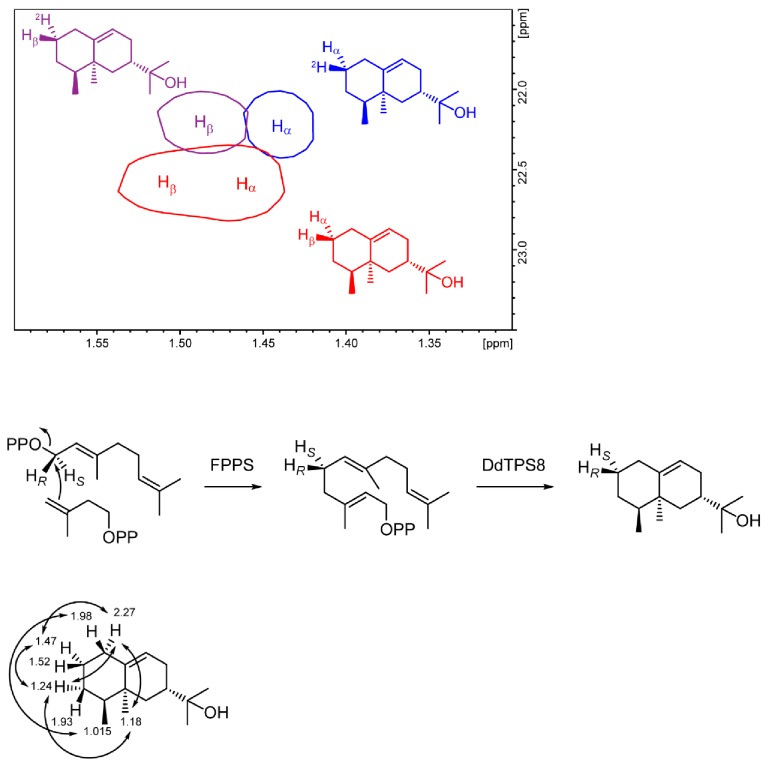
Determination of the absolute configuration of discoidol.